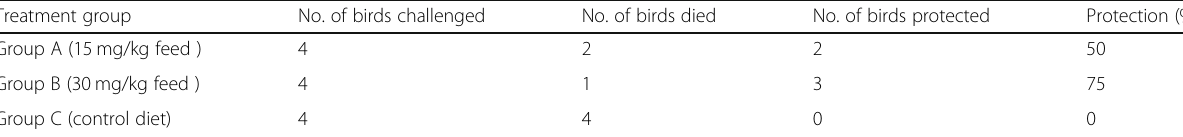
Table 1 Percent protection in control and treated broiler birds after virulent ND virus challenge Treatment group